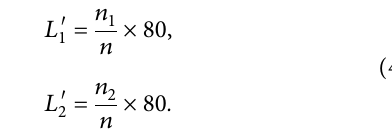
Figure 5: Flowchart for calculating the counterweight position. Here, S signal of the disk 1, and S 2 represents the Hall signal of the disk